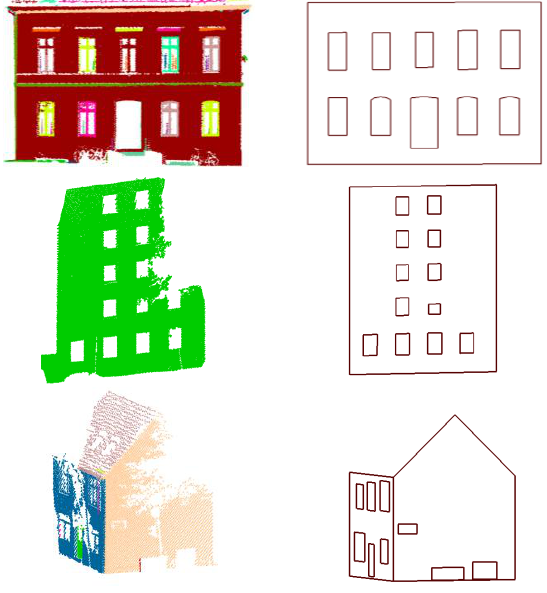
Figure 6: Modelling results of some selected walls (left – segmented points, and right – reconstructed